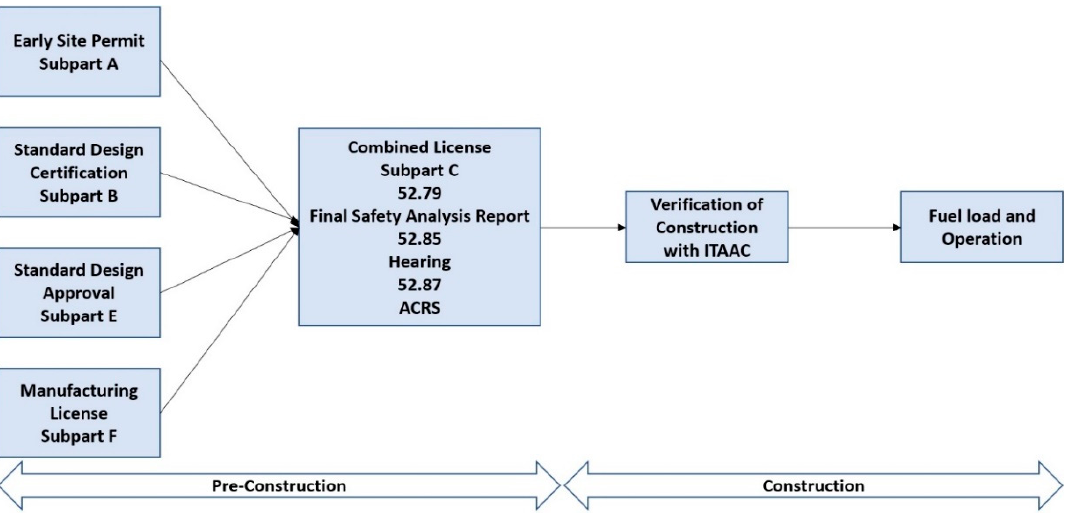
Figure 5. COL process of 10 CFR Part 52.